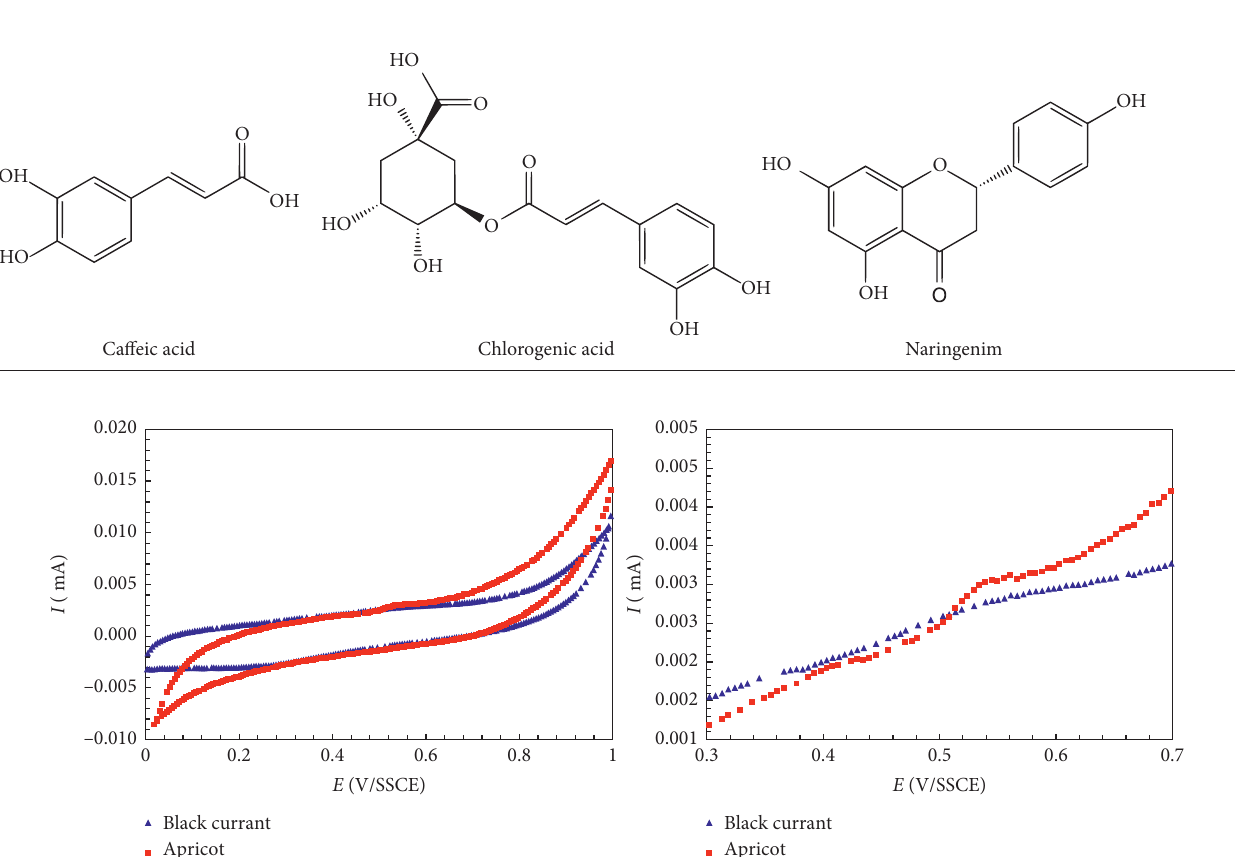
Figure 1: Cyclic voltammograms for the black currant and apricot pomace aqueous extracts. Scan rate: 100mV/s.